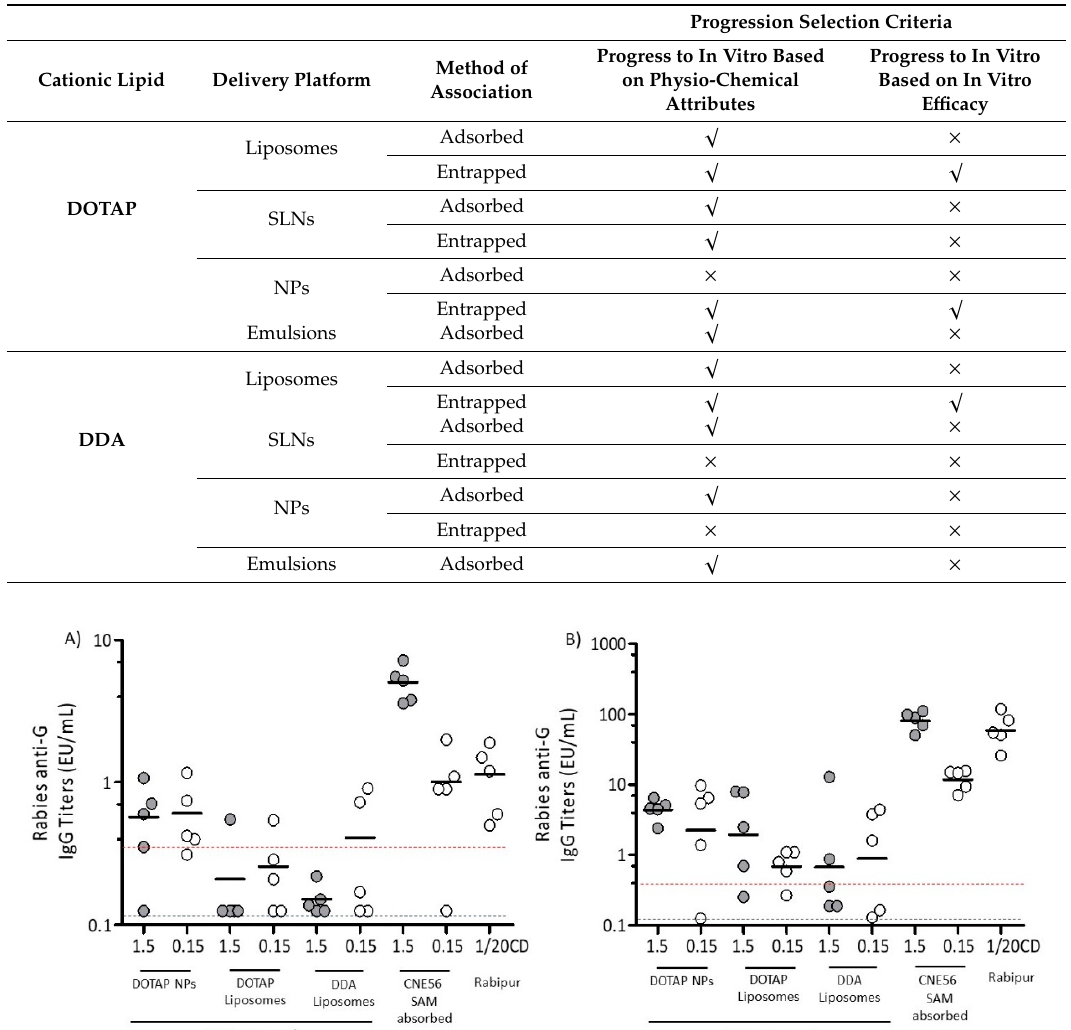
Table 2. Schematic representation of criteria applied to DOTAP- or DDA-based liposomes, solid lipid nanoparticles and emulsions to down-select formulations to progress to in vivo studies.